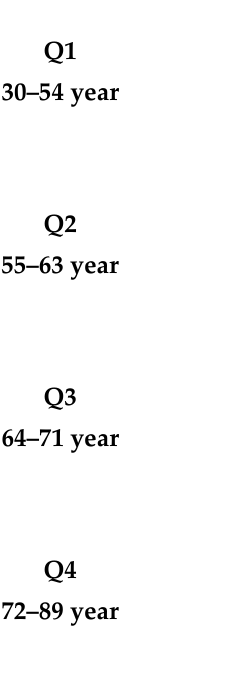
Figure 1. Scatter plot of Fe intake by food group according to age quartile.